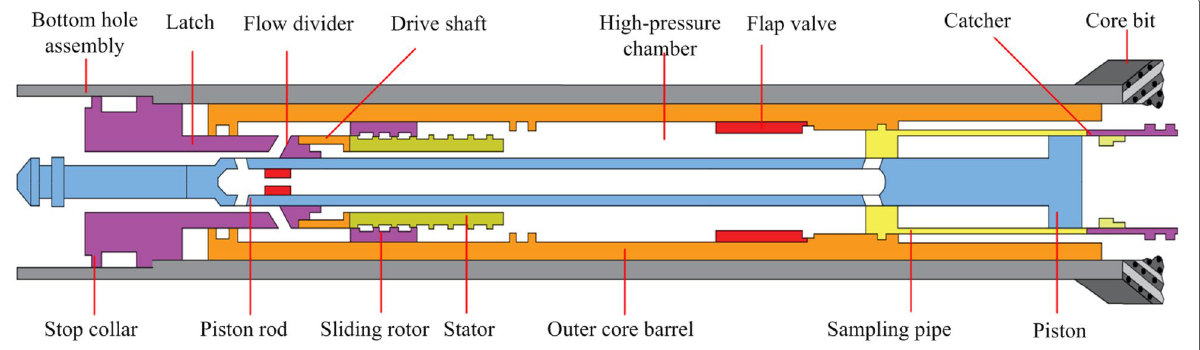
Figure 4 Schematic of the hydrate auto-clave coring equipment (HYACE)rotary corer